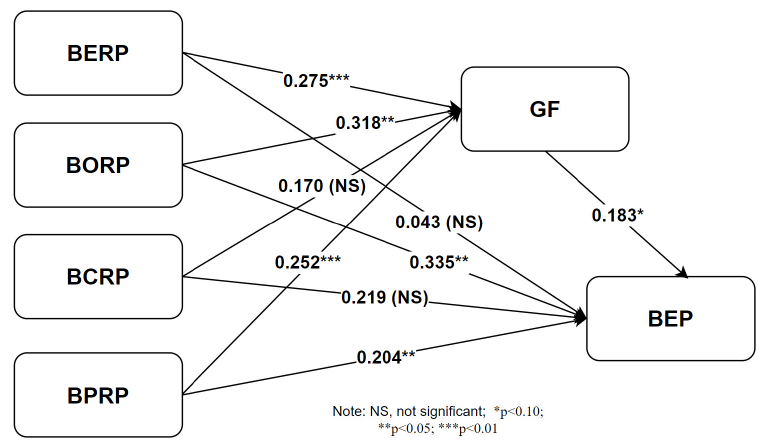
Figure 4. Estimated